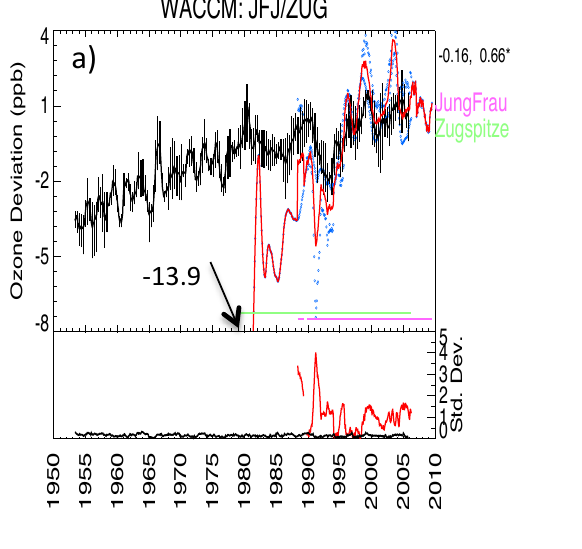
4 Long-term tropospheric ozone